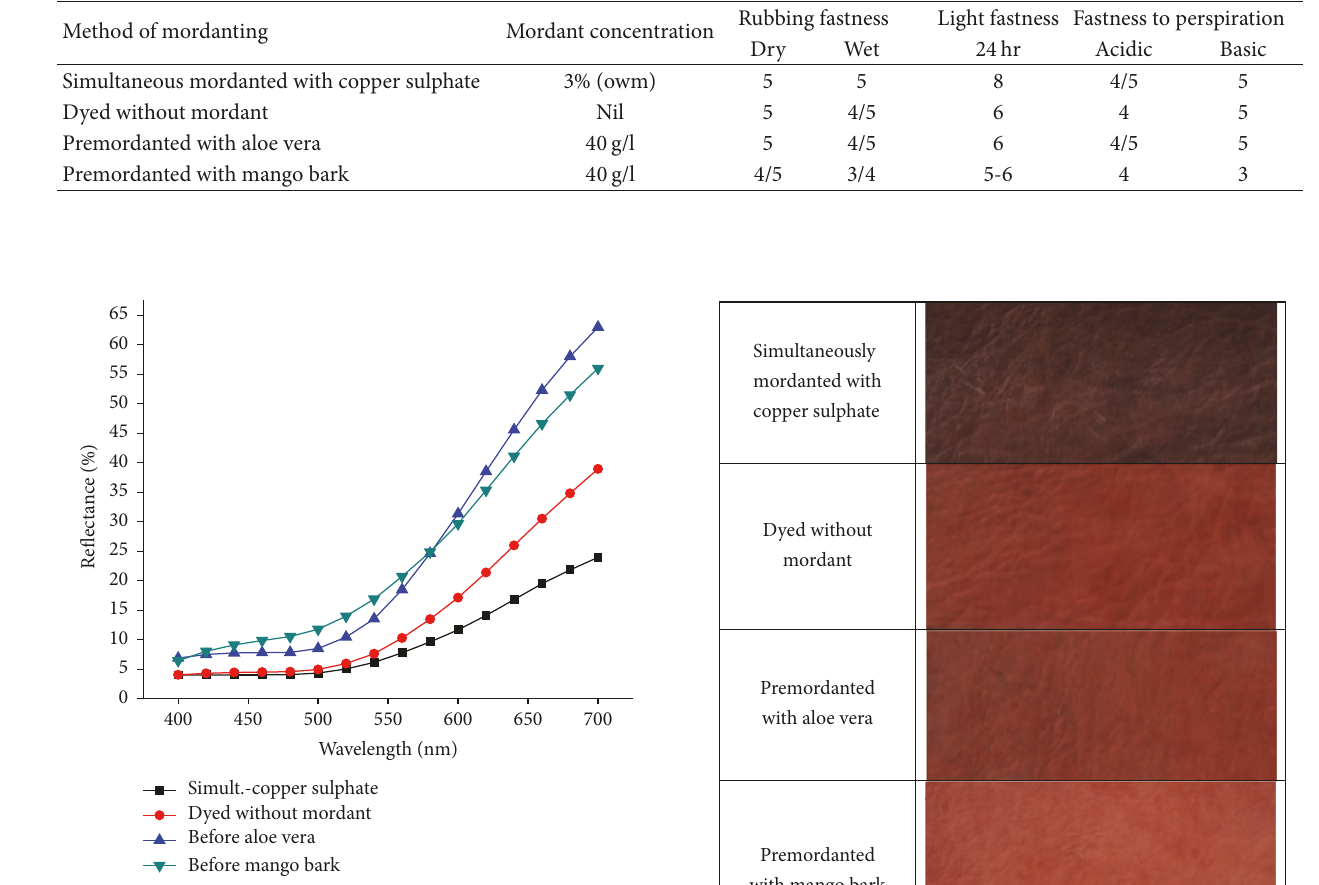
Figure 2: Reflectance spectra of selected dyed leather samples.